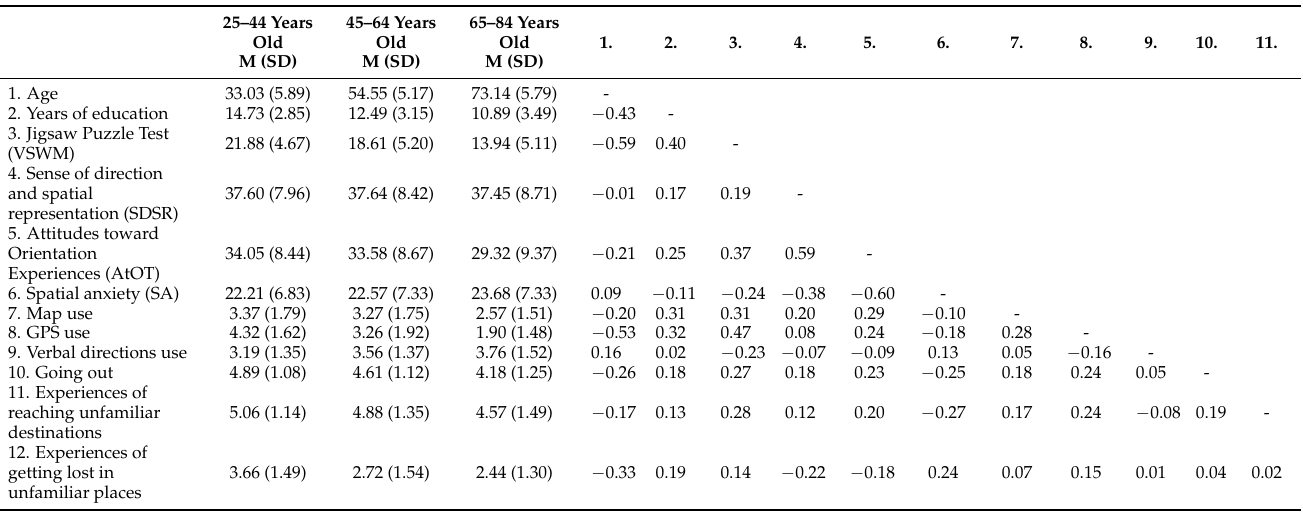
Table 1. Means and standard deviation of variables in the three age groups and correlations among